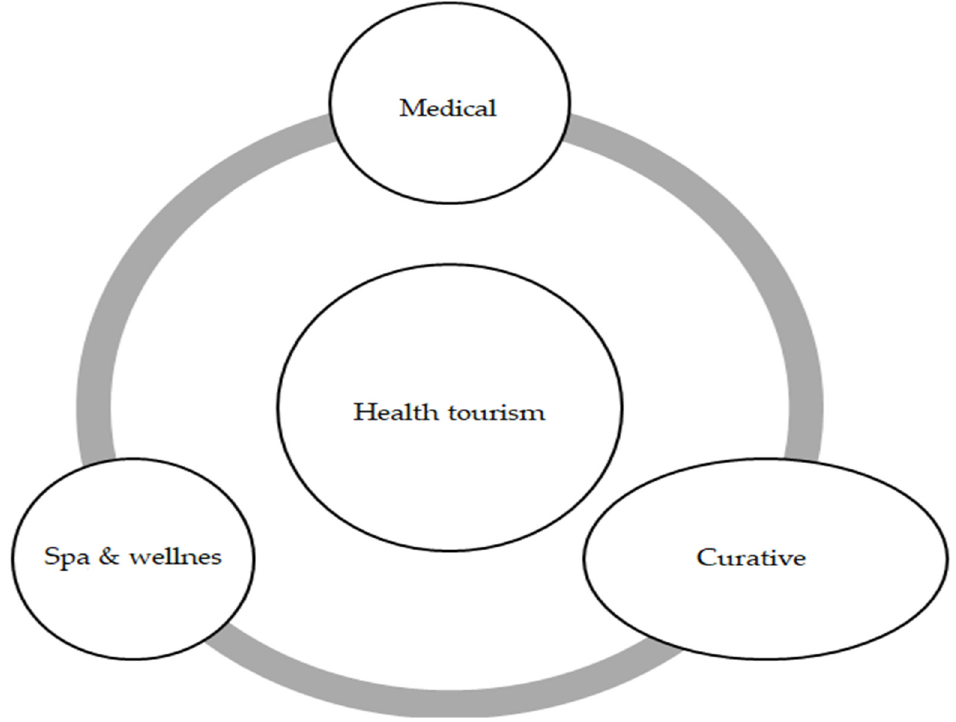
Figure 1. Division of health tourism. Source: [37,41].